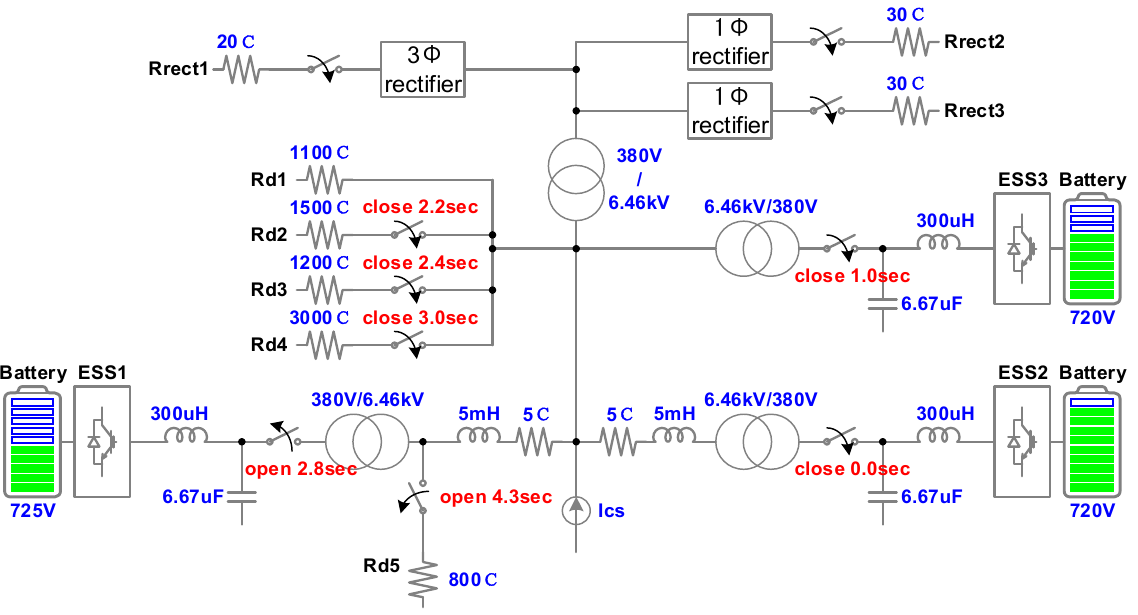
Figure 6. MG circuit for the proposed control method simulation.